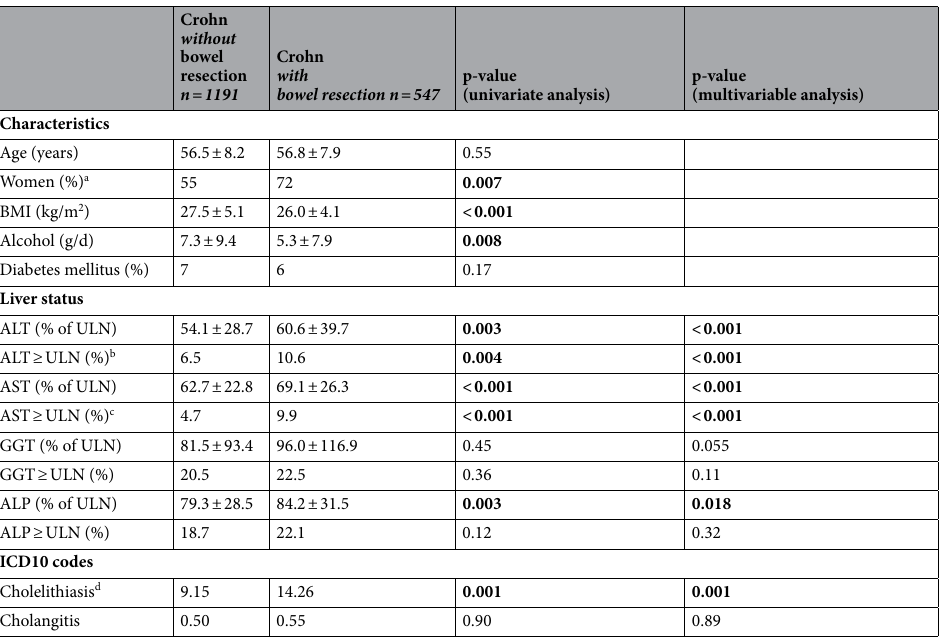
Table 3. Comparison of UK Biobank cohorts with Crohn’s disease that did/did not undergo bowel resection. Quantitative measures are expressed as mean with standard deviation or relative frequency (%). All analyses were adjusted for age, sex, BMI, presence of diabetes mellitus, and mean alcohol consumption. p-values <0.05 are highlighted in bold. a Unadjusted OR = 0.75[0.61–0.93]; b unadjusted OR = 1.71[1.18–2.47], adjusted OR = 2.02[1.38–2.98]; c unadjustedOR = 2.22[1.48–3.32], adjusted OR = 2.24[1.50–3.35]; d unadjusted OR = 1.65[1.21–2.25], adjusted OR =